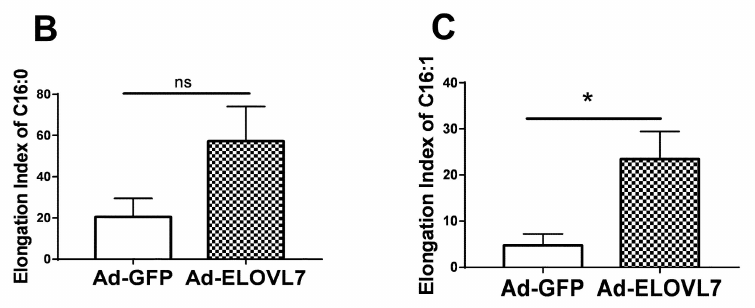
Figure 3. Overexpression of ELOVL7 altered the concentration of C16–C18 carbon fatty acids in goat mammary epithelial cells (GMEC). The GMEC were transfected with Ad-ELOVL7 or Ad-GFP for 48 h and then collected for fatty analysis. Data are reported as ratio of total fatty acids. Values are means ± SEM from 3 individual cultures. The data were determined via Student’s t-test. * p < 0.05 compared with control (Ad-GFP). ns represents no significant change compared with control (Ad-GFP).